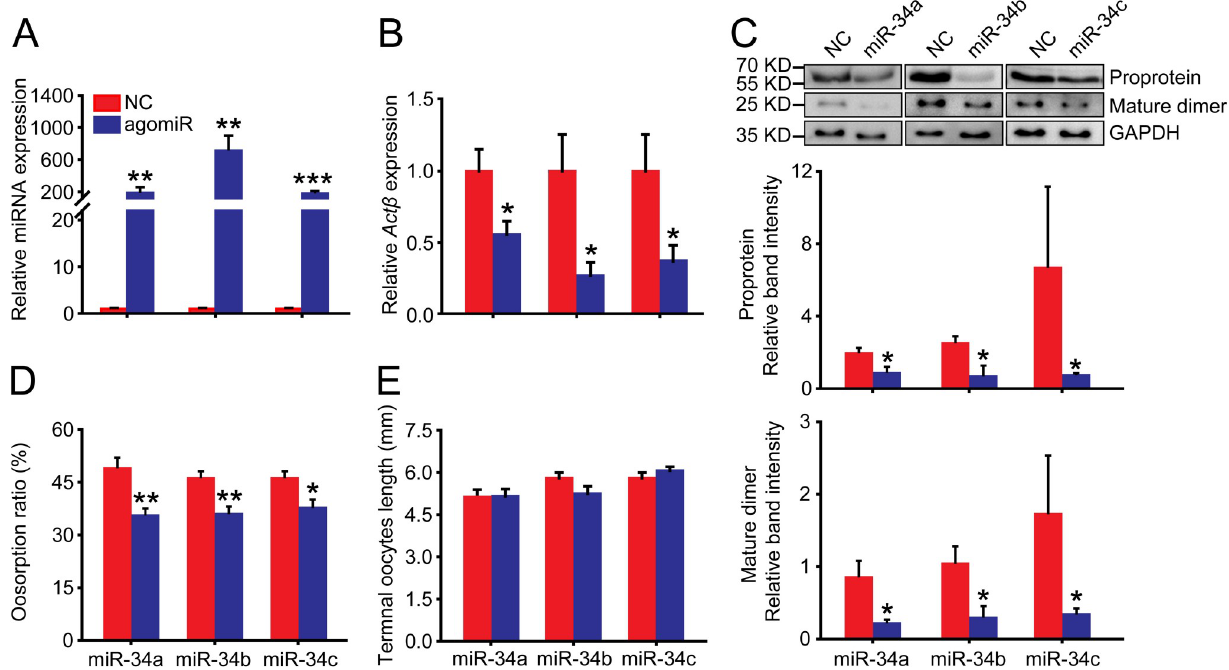
Fig 6. Effects of agomir-34 injection on oosorption in the gregarious locusts. (A) The relative miRNA abundance of miR-34a, miR-34b or miR-34c in the terminal oocytes after injection with respective agomirs. n = 7–8. (B) Gene expression level of Act β in the terminal oocytes after injection with agomir of miR-34a, miR-34b or miR-34c. n = 5–8. (C) Protein expression level of Act β in the terminal oocytes after injection with agomir of miR-34a, miR-34b or miR-34c. n = 4. (D) Oosorption ratios after injection with agomir of miR-34a, miR-34b or miR-34c. n = 10–13. (E) Length of terminal oocytes after injection with agomir of miR-34a, miR-34b or miR-34c. n = 8–13. � P < 0.05, �� P < 0.01, ��� P < 0.001.